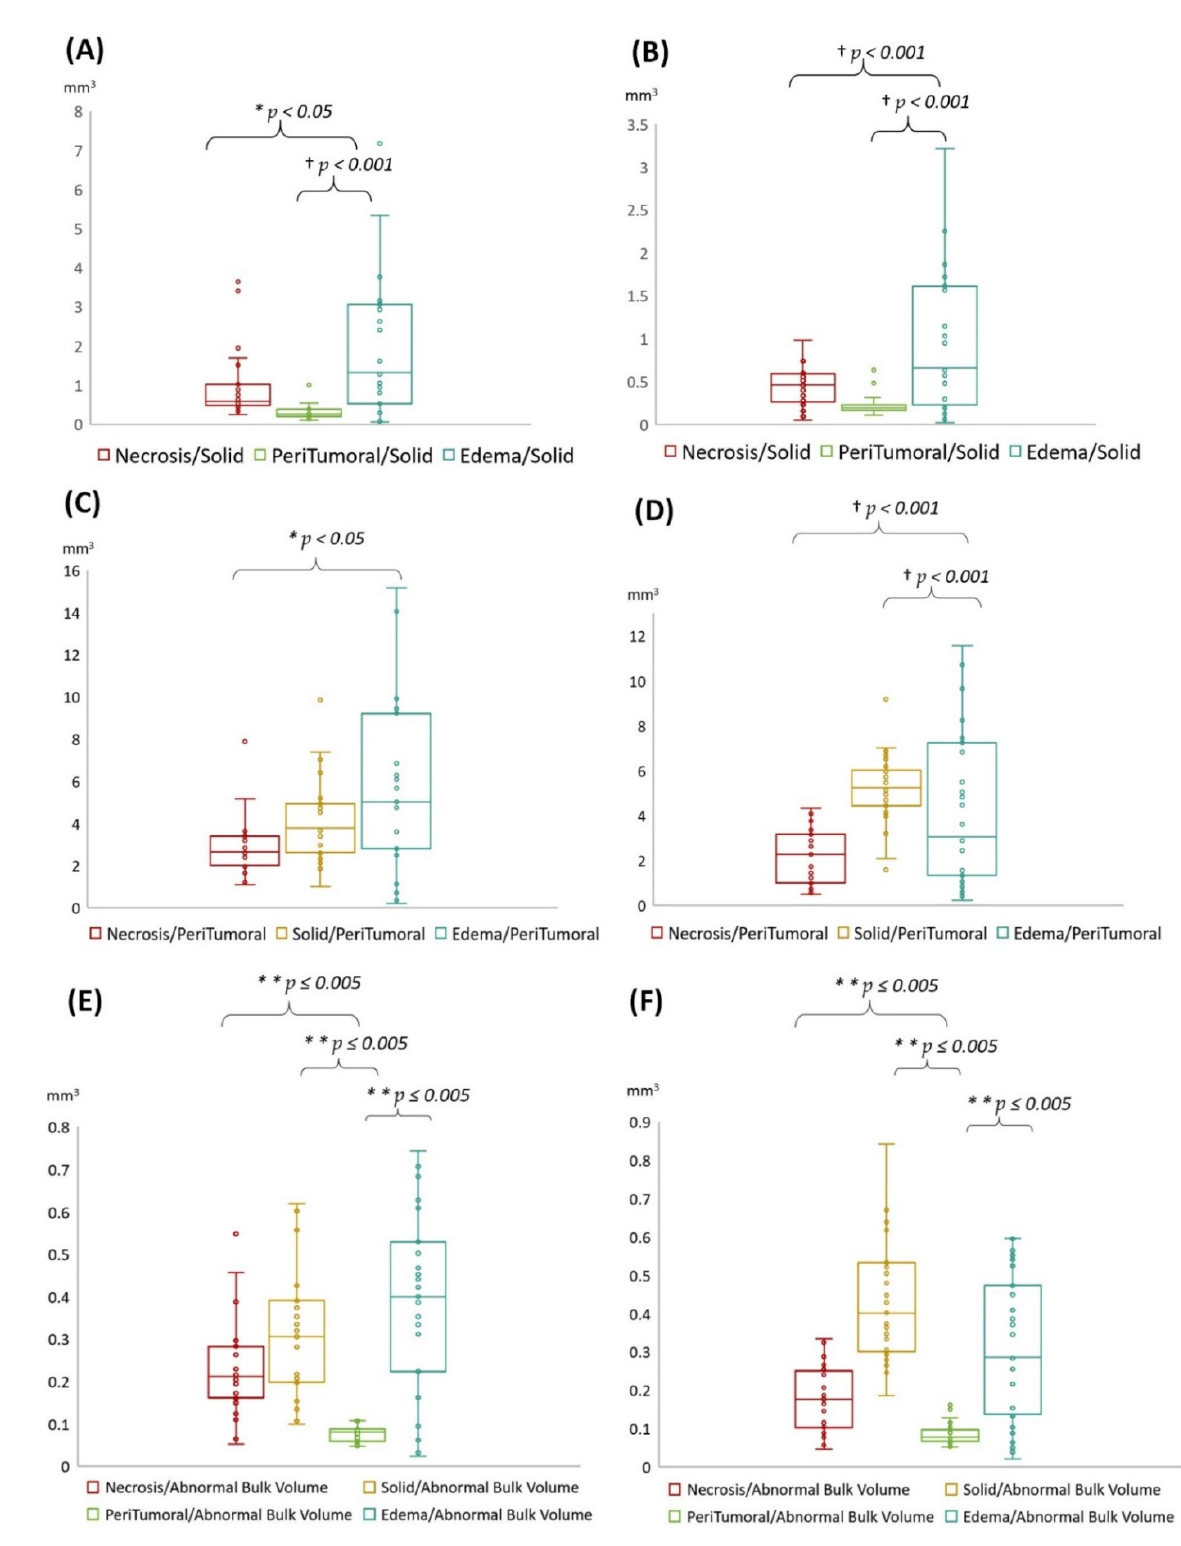
Figure 4. Box-and-whisker plot shows the volumetric size distribution of subregion ratio types for two cohorts in local ( A,C,E ), and TCIA ( B,D,F ) on multi ‐ parametric MR images. ( A – F ) show representative different subregions to solid tumor, peritumoral tissue, and abnormal bulk volume ratio, respectively. Repeated ‐ measures ANOVA with Bonferroni correction. Statistically significant difference between each group p < 0.05 (*), p ≤ 0.005 (**), and p < 0.001 (†).